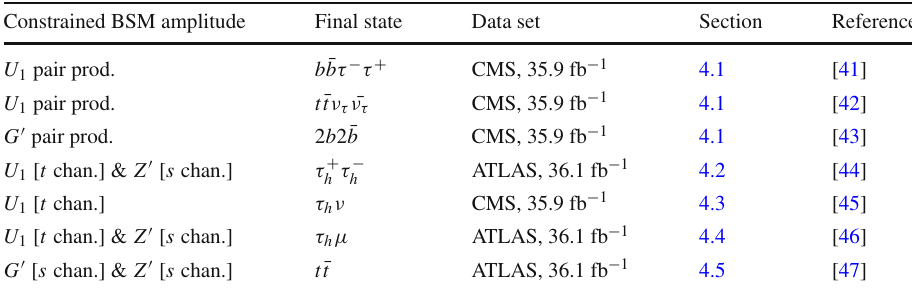
Table 1 Summary of the relevant experimental constraints. All searches have a centre of mass energy of 13